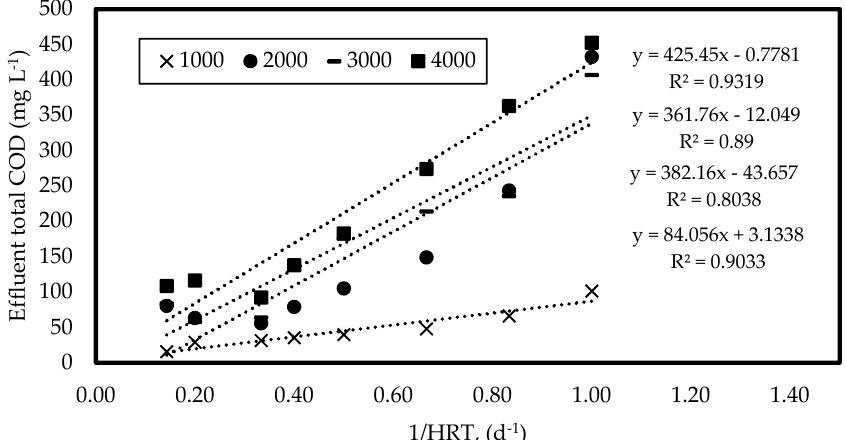
Figure 6. Estimation of nonbiodegradable fraction of total COD.